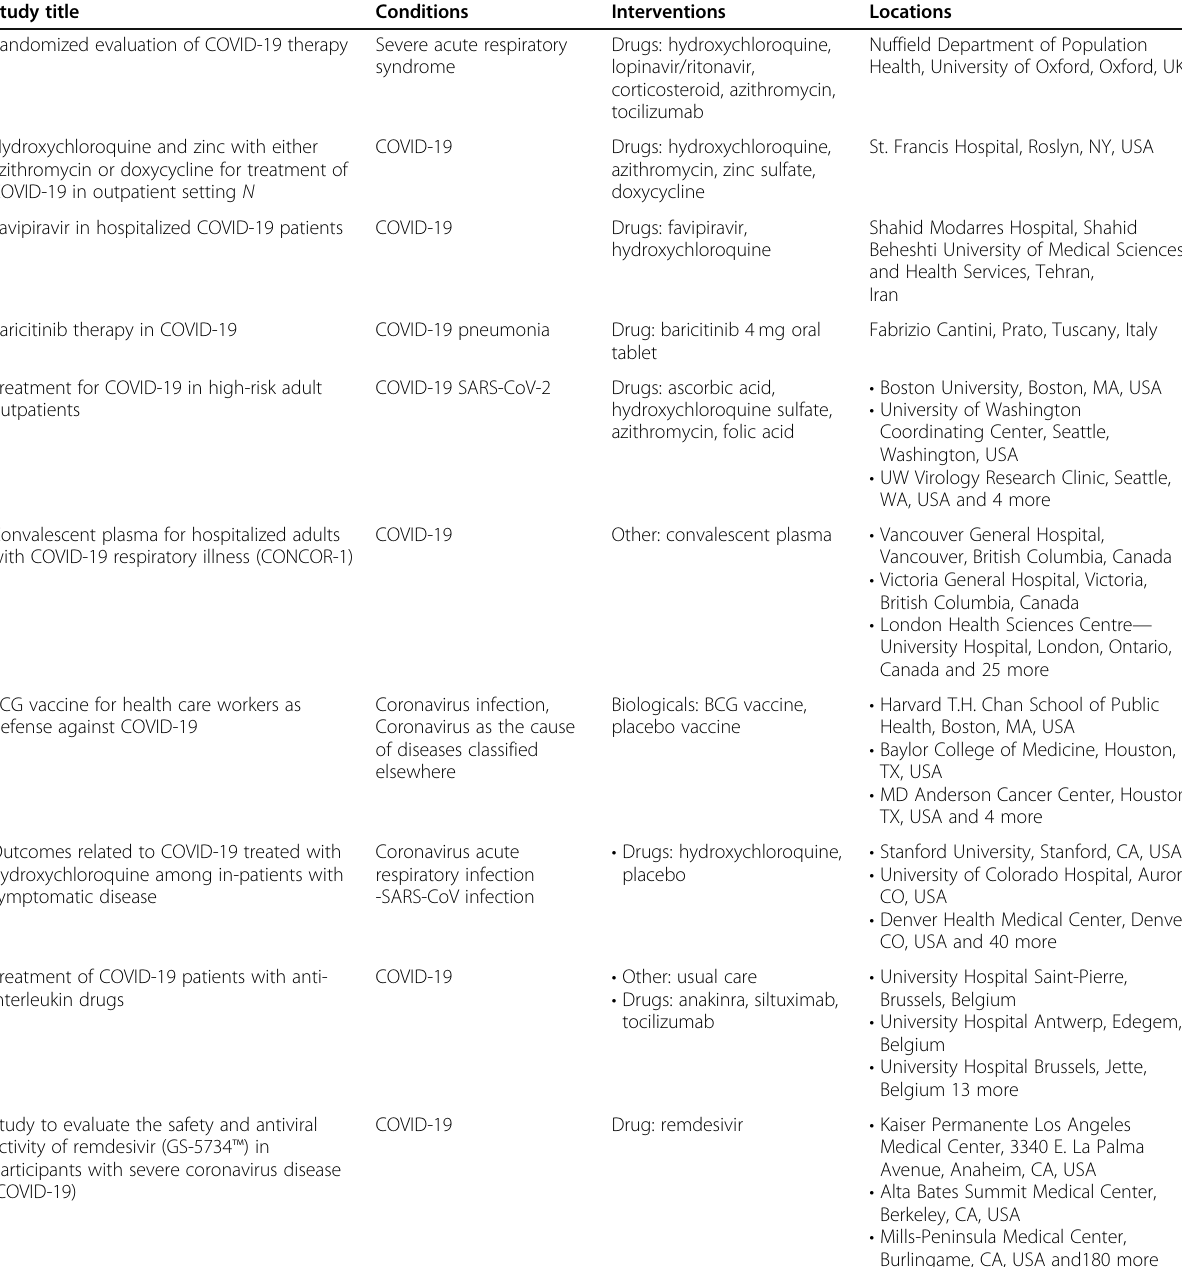
Table 6 Ongoing clinical trials phase 3